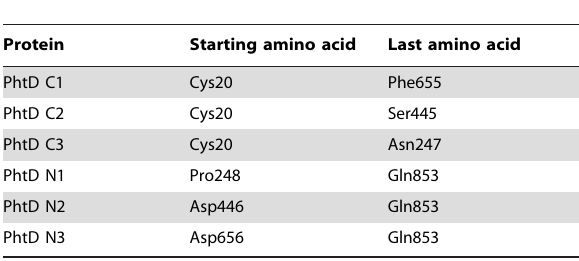
Table 1. List of starting and ending amino acids of PhtD truncated